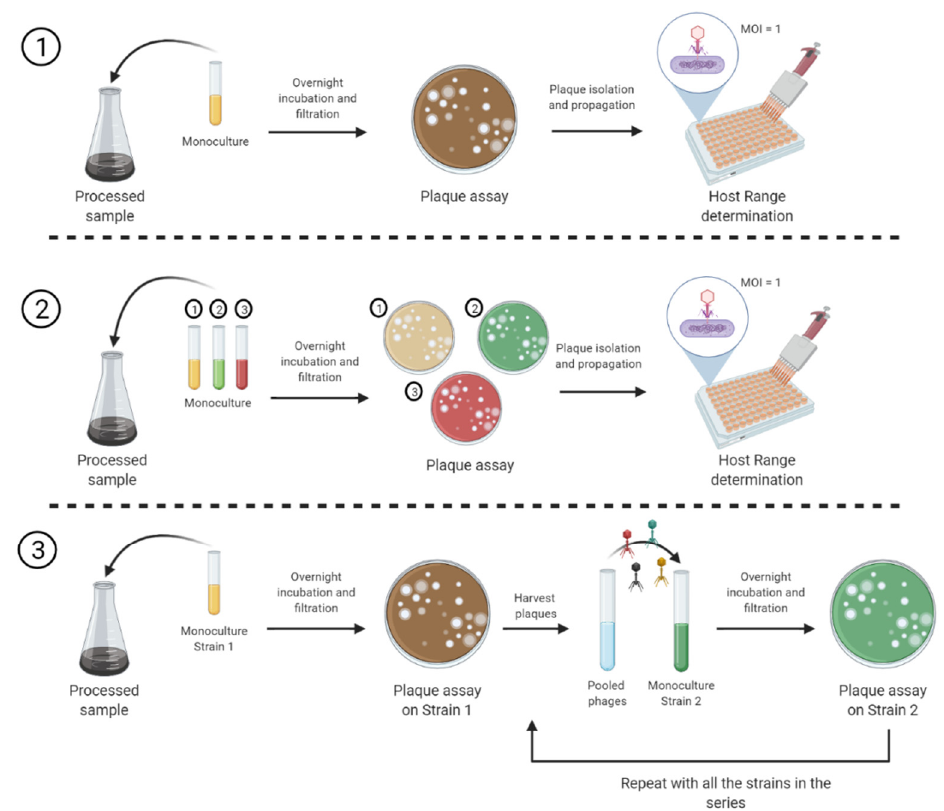
Figure 1. Methods for bacteriophage enrichment and isolation evaluated in this study. ( 1 ) Single strain (SS): processed sample is enriched with an overnight monoculture and incubated overnight.